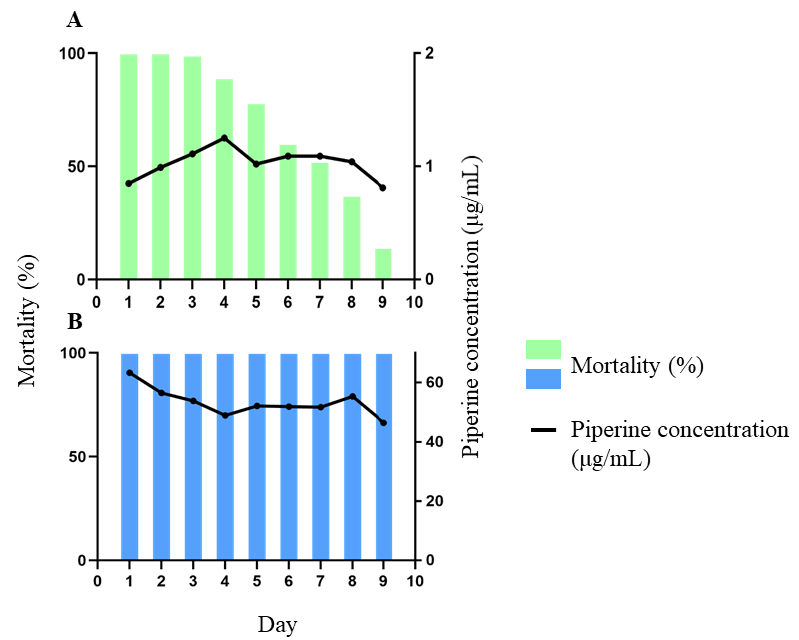
Figure 5. Residual larvicidal activity against Aedes aegypti (L3) and piperine quantification: ( A ). Piper nigrum standardized extract (green), initial concentration 4 μg/mL; ( B ). Piperine (blue), initial concentration 60 μg/mL.